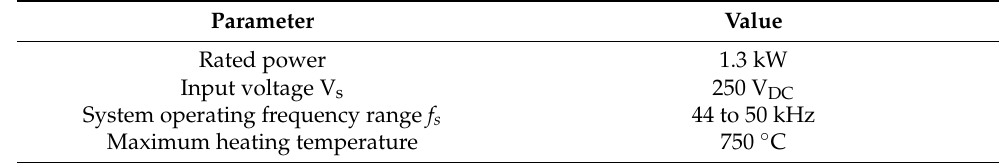
Table 3. Specification of the full-bridge LC series resonant converter.